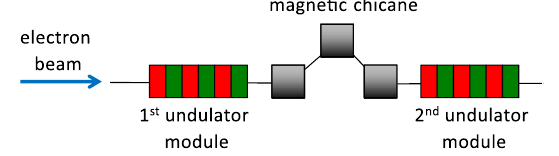
FIG. 1. Schematic layout of the proposed scheme for control- ling and measuring the intrinsic energy spread of electron